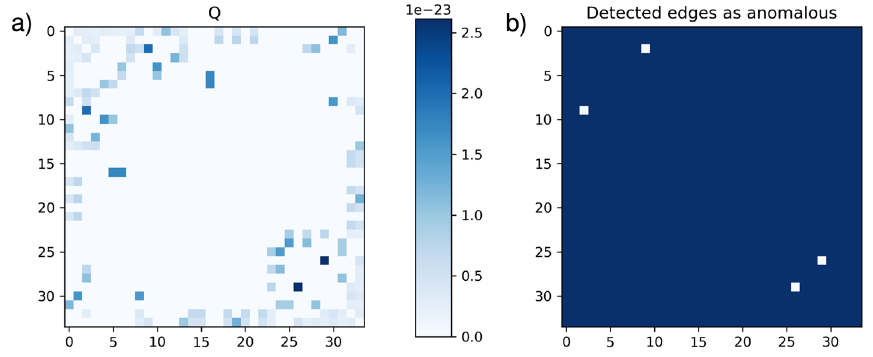
Fig. 9 The network of Zachary karate Club (Experiment 1). a Q matrix, estimated by ACD, as the expected value of Z ij over the variational distribution. b The inferred anomalous edges, i.e., the entries of Q with the values above the threshold, here, the threshold